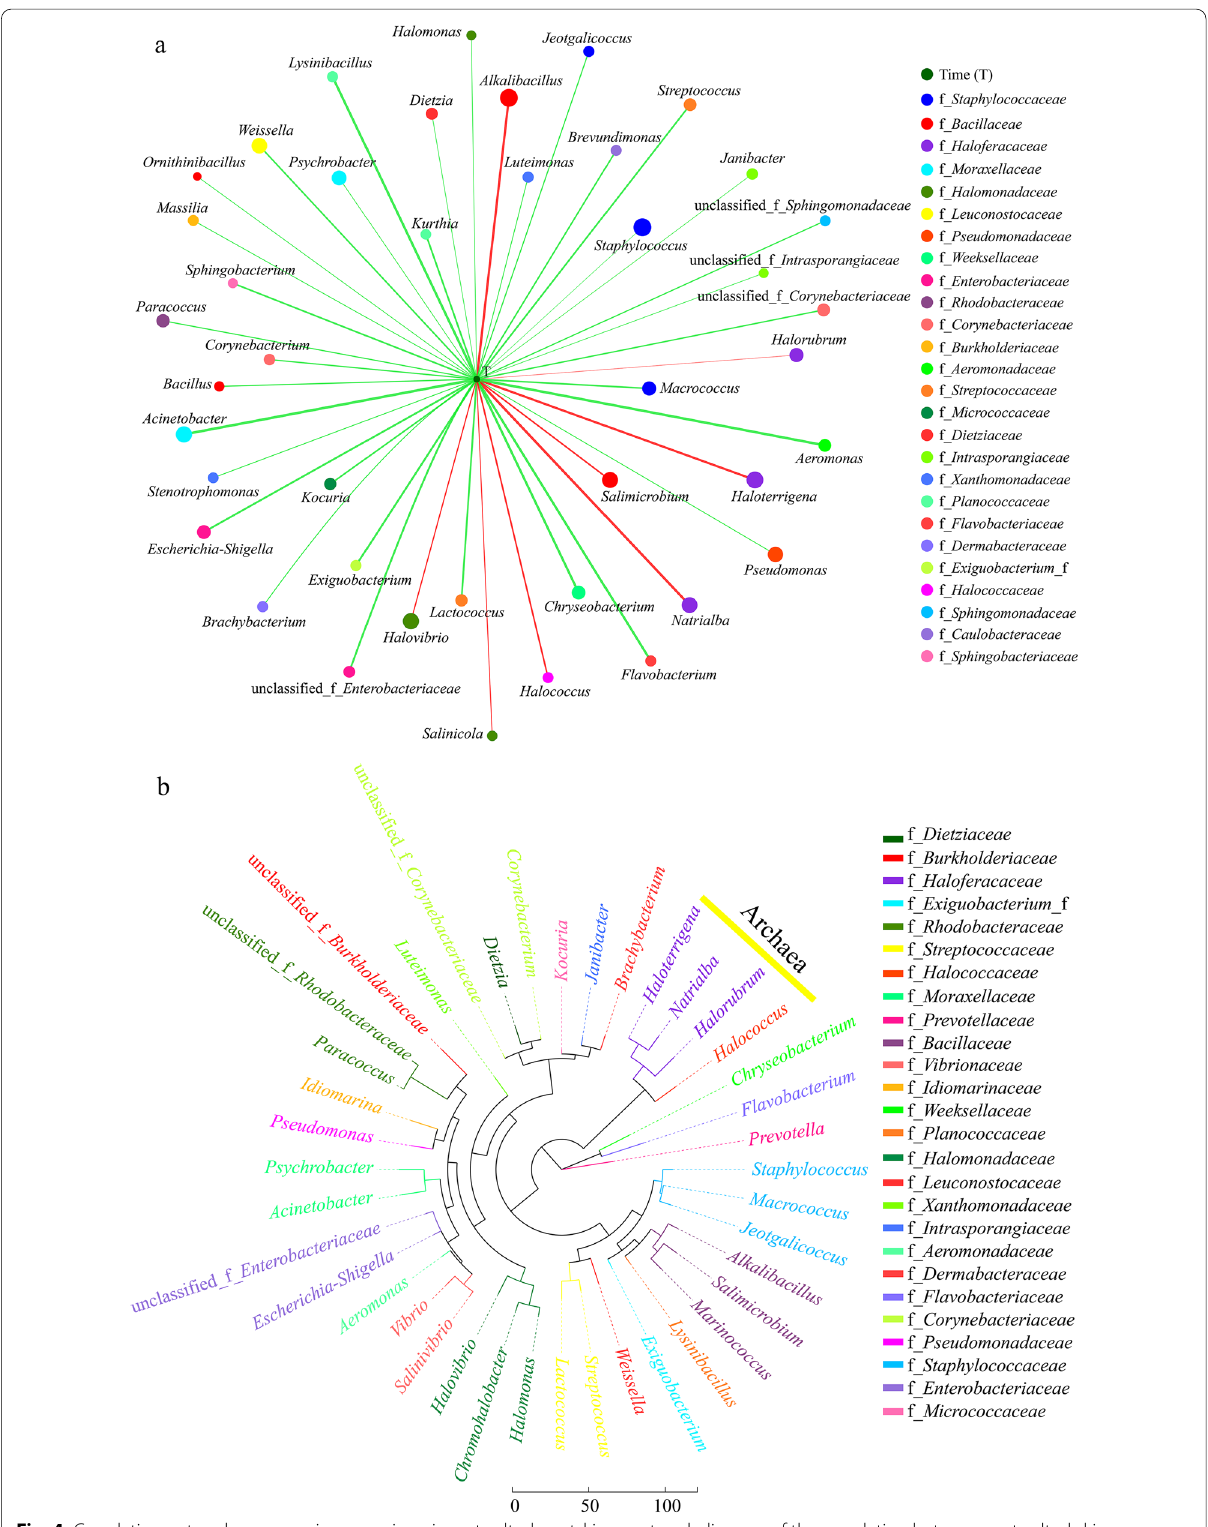
Fig. 4 Correlation network among microorganisms in wet-salted goatskin. a network diagram of the correlation between wet-salted skin microorganisms and time. Red lines indicate a positive correlation, green lines indicate a negative correlation; thicker lines indicate a higher correlation between the two, and more lines indicate a stronger connection with the node. b phylogenetic relationships among microorganisms on wet-salted goatskin. c composition of unique and shared bacteria in 17 microbial samples